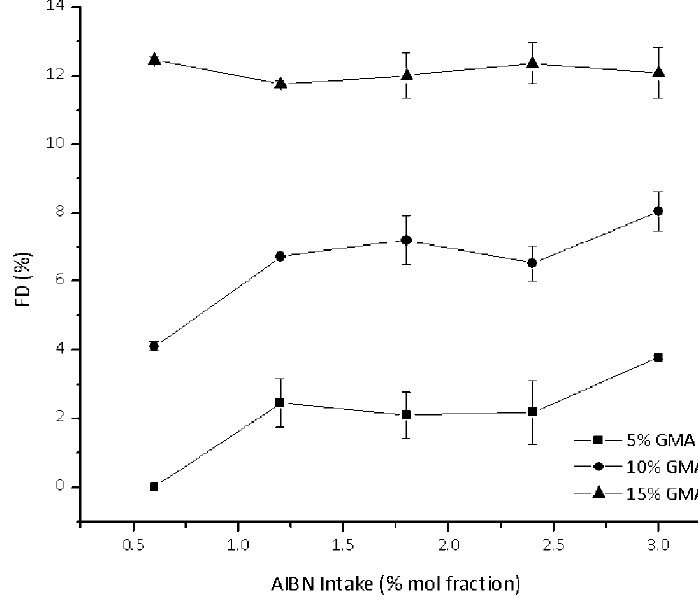
Figure 4. Effect of AIBN intake on the FD values of PCL- g -GMA.